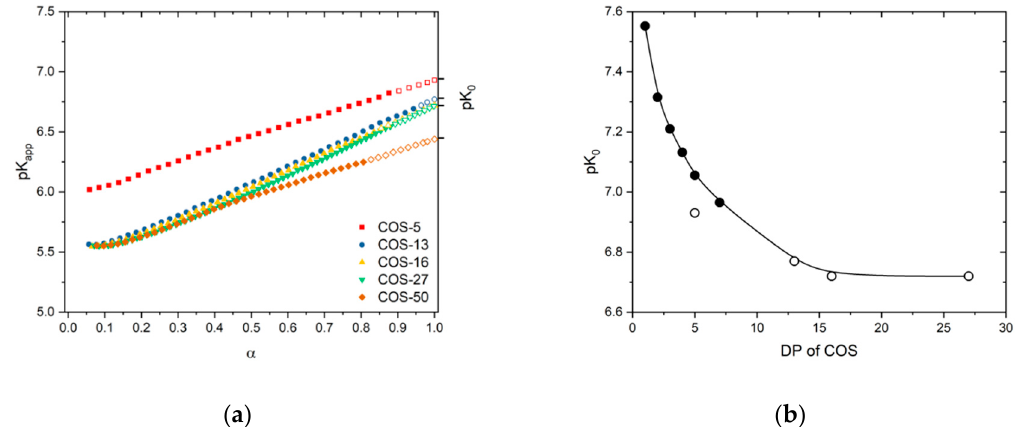
Figure 1. The variation of the apparent pK a of COS as a function of the degree of dissociation ( a ). The open symbols correspond to extrapolated values. The concentration of COS is 1 g/L. ( b ) The variation of the intrinsic dissociation constant (pK 0 ) as a function of the degree of polymerization (DP) (open symbols). The data are plotted together with those in Ref. [26] obtained on isomolecular COS fractions of DP 1 to DP 7 (closed symbols). The line was added to guide the eye.